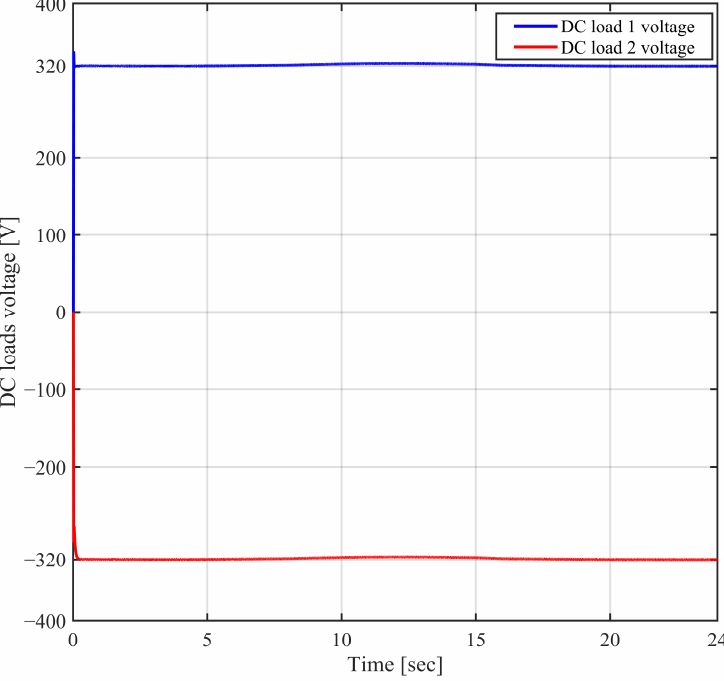
Figure 16. DC load voltage values in the LVDC distribution.